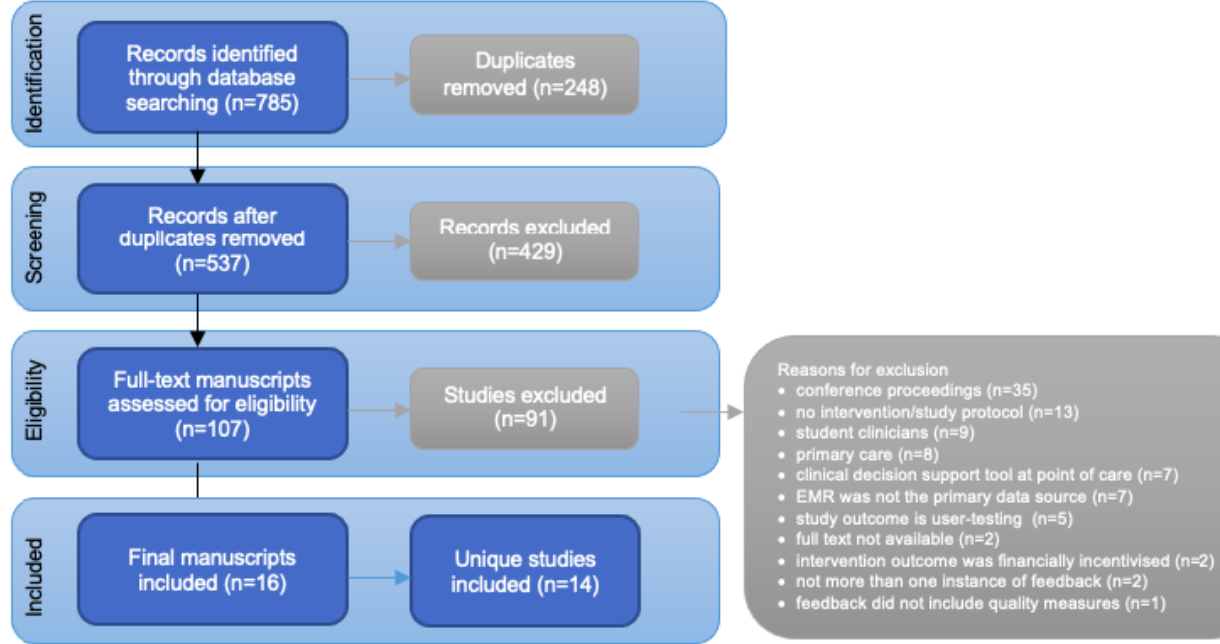
Figure 1. PRISMA flow-diagram shows the process of identifying records from database searches, screening abstracts and full-text manuscripts against the inclusion/exclusion criteria, and final in- cluded studies.